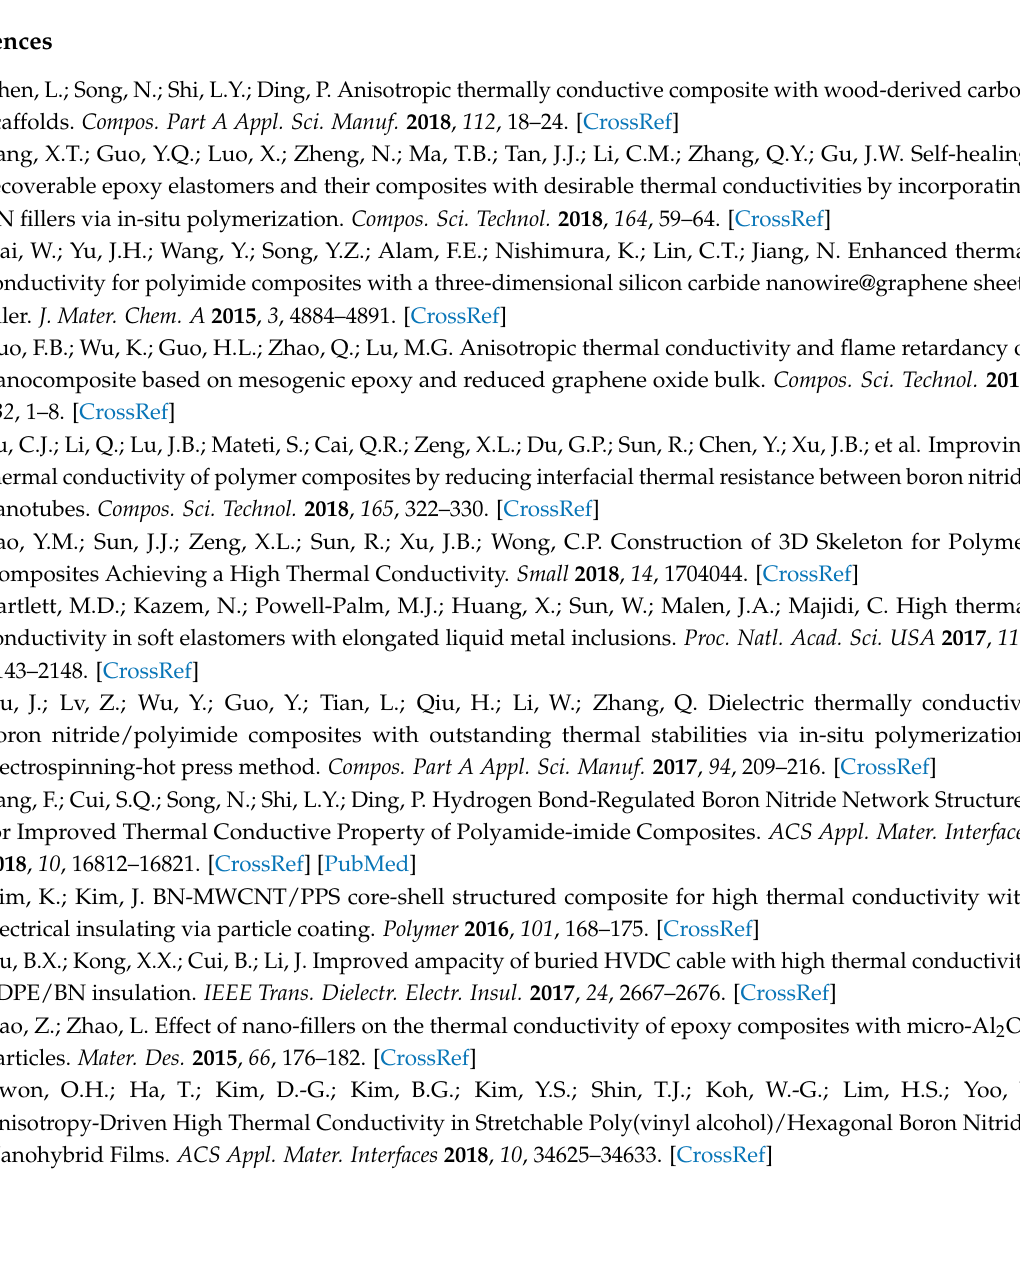
Figure S1: Digital image of GO/PEO-R2 and GO/PEO-R3, Figure S2: Thermal conductivity of GO and GO/PEO composite films (a) In-plane, (b) Out